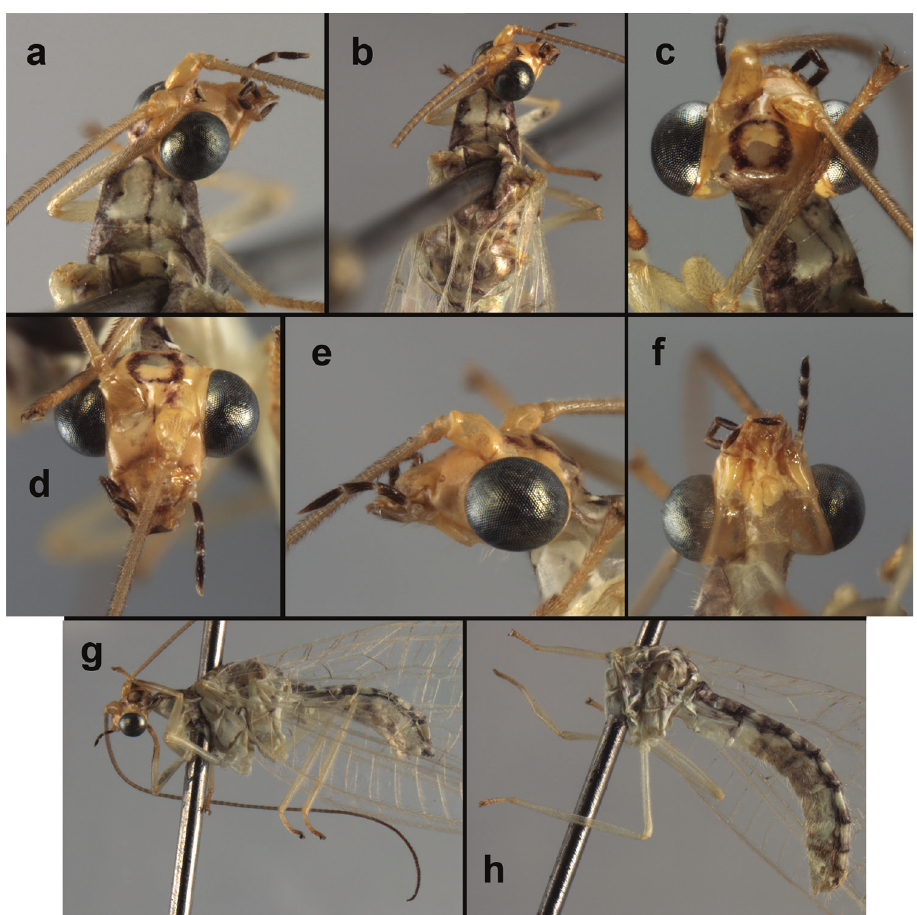
Figure 68. Ungla pallescens Penny: External features, ( a ) head, prothorax, dorsolateral, dorsal ( b ) head, thorax, dorsal ( c ) head, dorsal ( d ) head, frontal ( e ) head, lateral ( f ) head, ventral ( g, h ) body, lateral (all: Costa Rica, Monteverde, paratypes, CAS; a–g female; h male, slightly teneral).